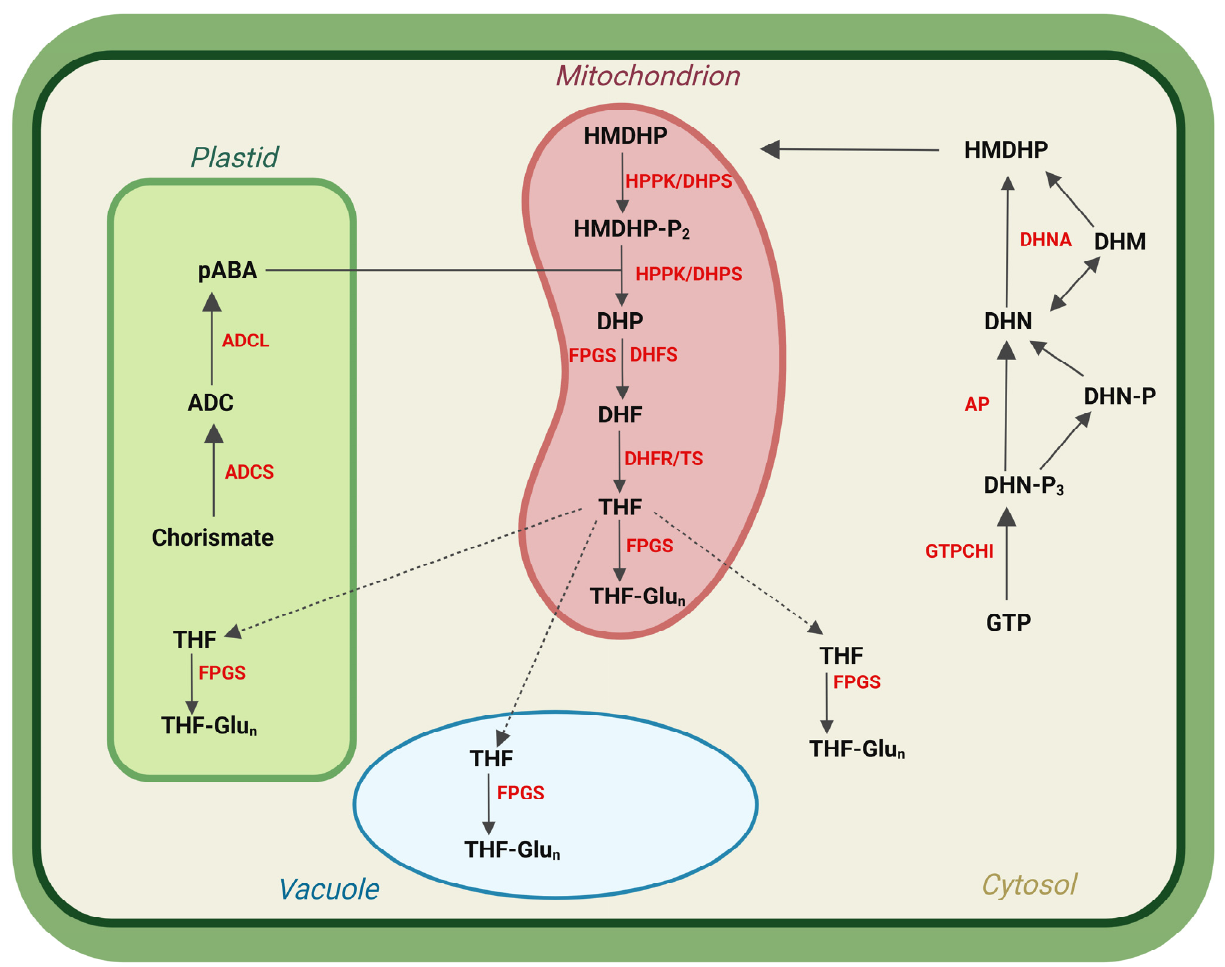
Figure 3. Schematic representation of the folate pathway in soybean as extracted from the KEGG soybean folate biosynthesis pathway [77]. Compound abbreviations: GTP, guanosine triphosphate; DHN-P 3 , dihydroneopterin triphosphate; DHN-P, dihydroneopterin monophosphate; DHN, dihy- droneopterin; DHM, dihydromonapterin; HMDHP, 6-hydroxymethyldihydropterin; HMDHP-P 2 , 6-hydroxymethyldihydropterin pyrophosphate; DHP, dihydropteroate; DHF, dihydrofolate; THF, tetrahydrofolate; Glu, glutamate. Folate biosynthesis enzymes: ADCS, ADC synthase; ADCL, ADC lyase; GTPCHI, GTP cyclohydrolase 1; AP, alkaline phosphatase; DHNA, DHN aldolase; HPPK/DHPS, dihydropterin pyrophosphokinase-dihydropteroate synthase; DHFS, dihy- drofolate synthetase; DHFR/TS, dihydrofolate reductase-thymidylate synthase; FPGS,